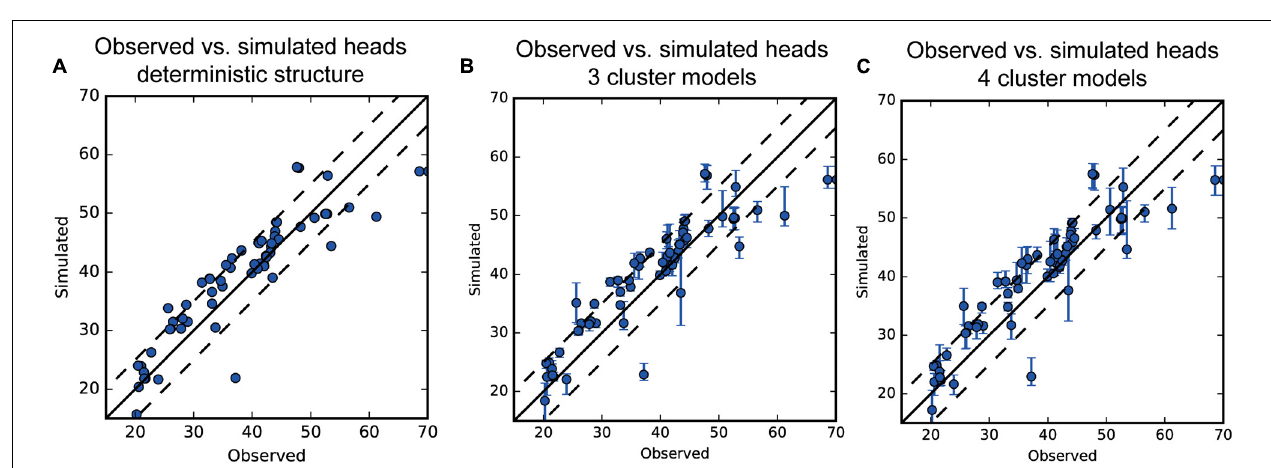
FIGURE 9 | Observed vs. simulated steady state heads. (A) Deterministic model structure, (B) 3 Cluster models, (C) 4 cluster models. Dotted lines show the plus and minus 5 m offsets from the identity